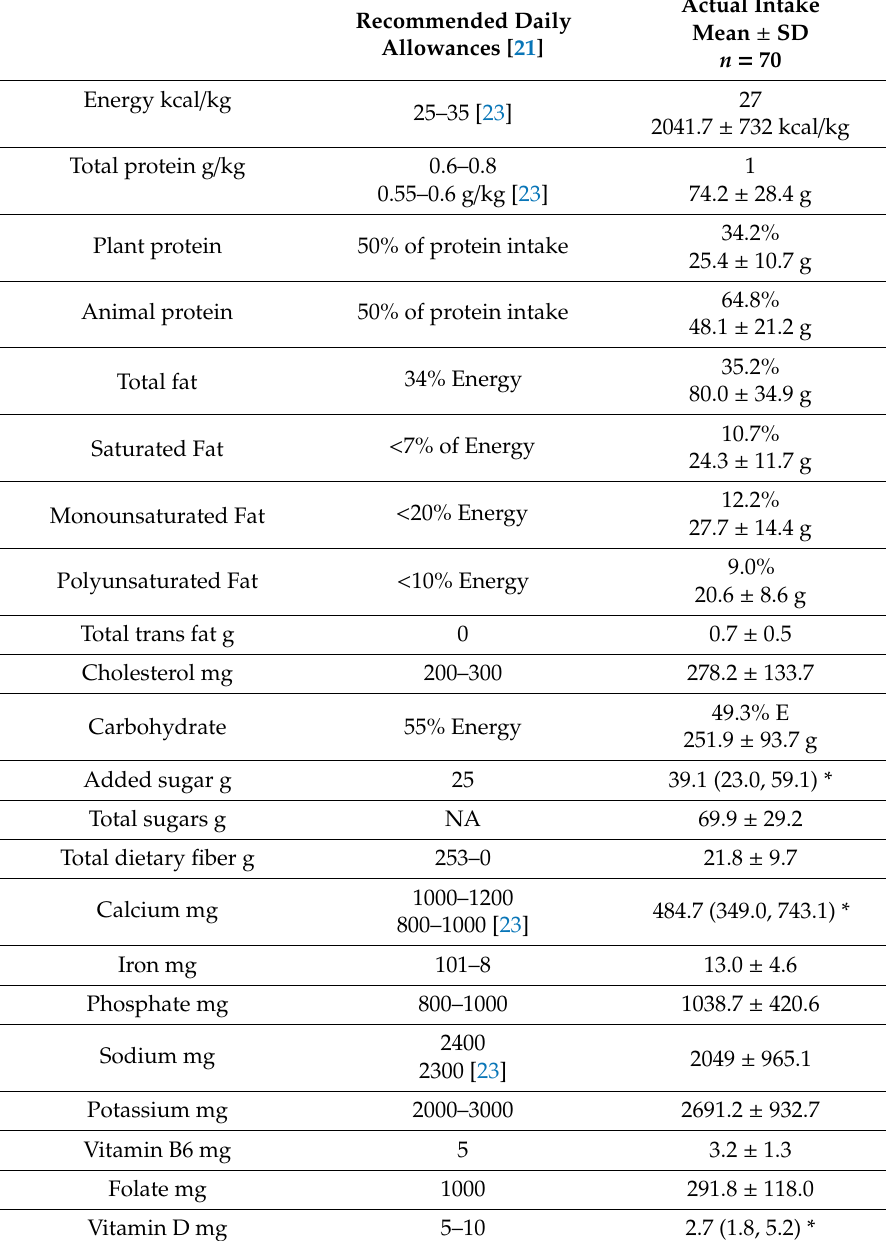
Table 4. Recommended intakes versus actual intake of